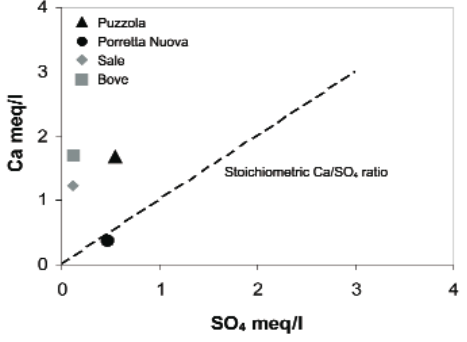
Fig. 8. Ca versus SO 4 contents for the collected water samples showing a clear Ca enrichment.Only Porretta Nuova falls on the stoichiometric Ca/SO 4 ratio line.